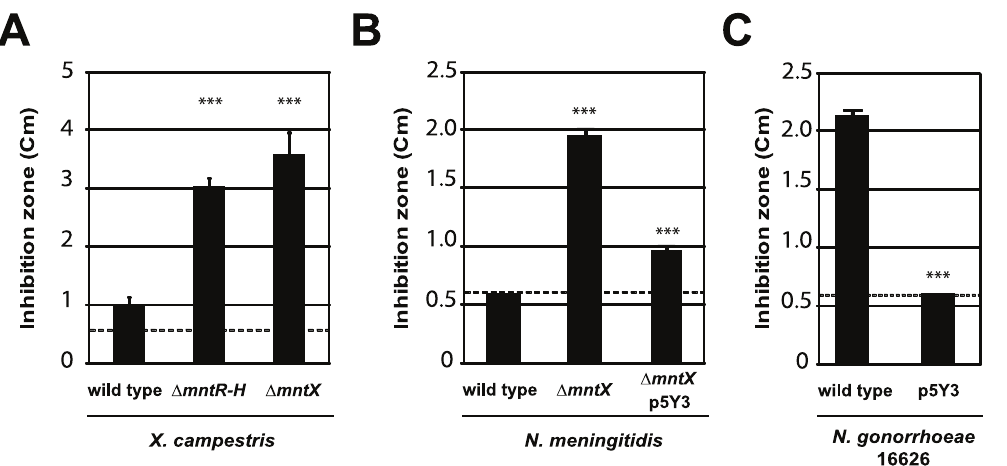
Figure 3. MntX which confers Mn resistance, is often not functional in N.gonorrhoeae . Disk assay of bacterial sensitivity to 1M MnCl 2 was carried out for A) X. campestris wild type and mutants lacking mntH and mntR or mntX. B) N. meningitidis MC58 wild type, lacking mntX or back complemented (insertion of p5Y3 by double recombination). C) N. gonorrhoeae 16626 wild type or transformed with mntX from N. meningitidis . These experiments done in triplicates are representative of several experiments (*** p , 0.01 compare to the wild type